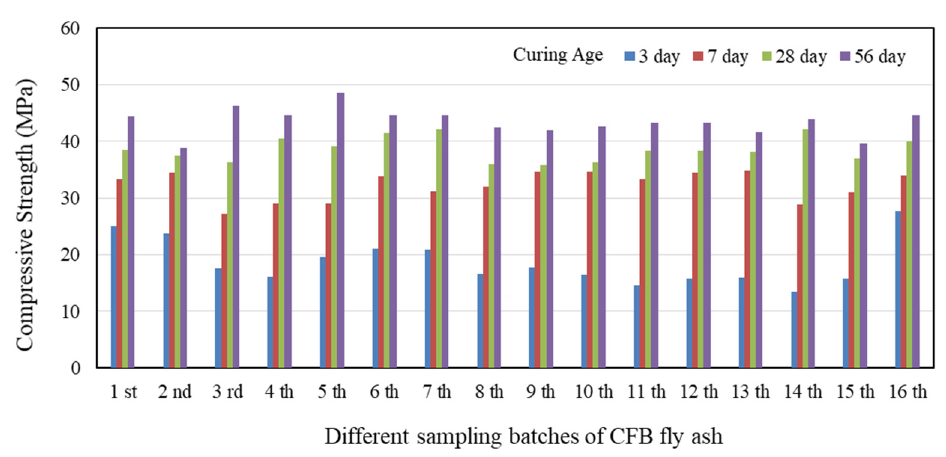
Figure 2. The compressive strength development of mortar specimens made using 16 different batches of CFB fly ash. Table 3. Statistical analysis on the compressive strength of CFB fly ash-BFS-cement mixed mortar (16 samplings).